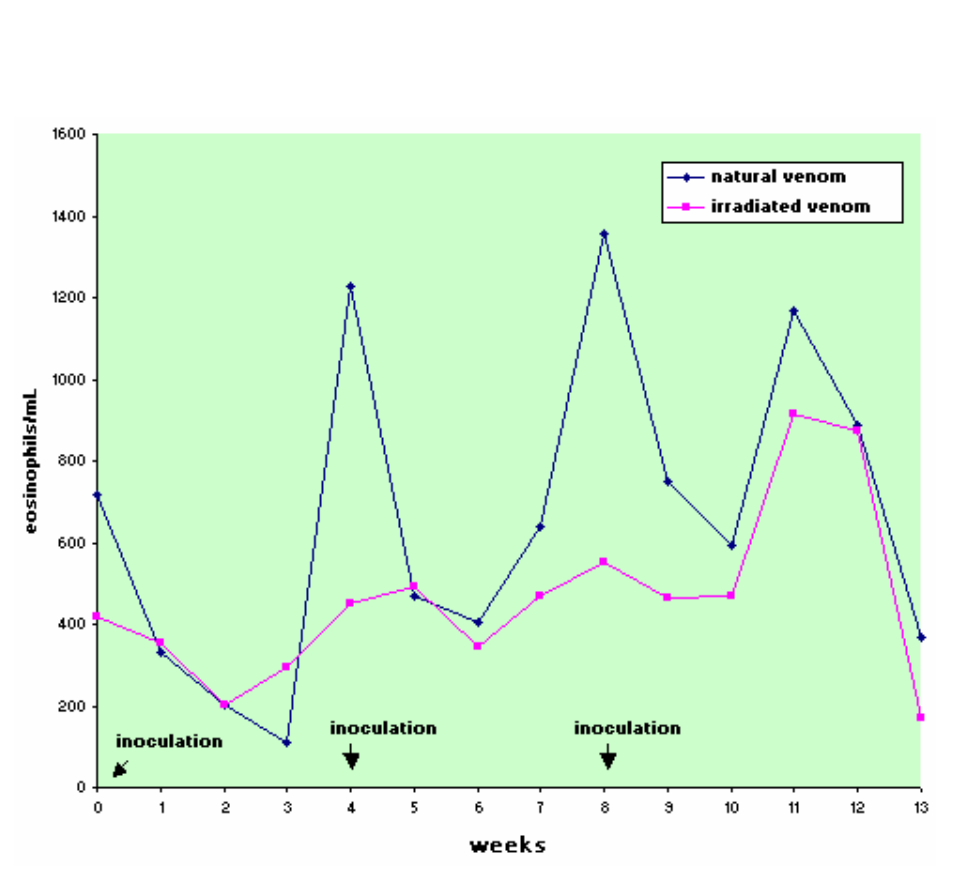
Figure 3. Means of eosinophils count using sheep (n=12) sera inoculated with natural (NV) Cobalt -irradiated (IrV) crotalic 60